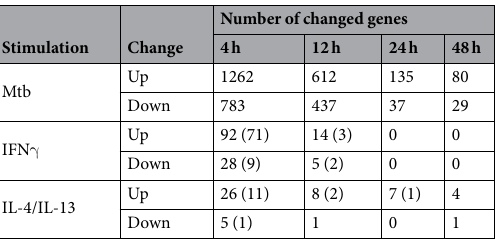
Table 1. Number of differentially expressed protein coding genes at each time point IFN γ and IL-4/IL-13 stimulated samples have parenthesis which indicates number of the overlapped genes with Mtb infection at that time point.